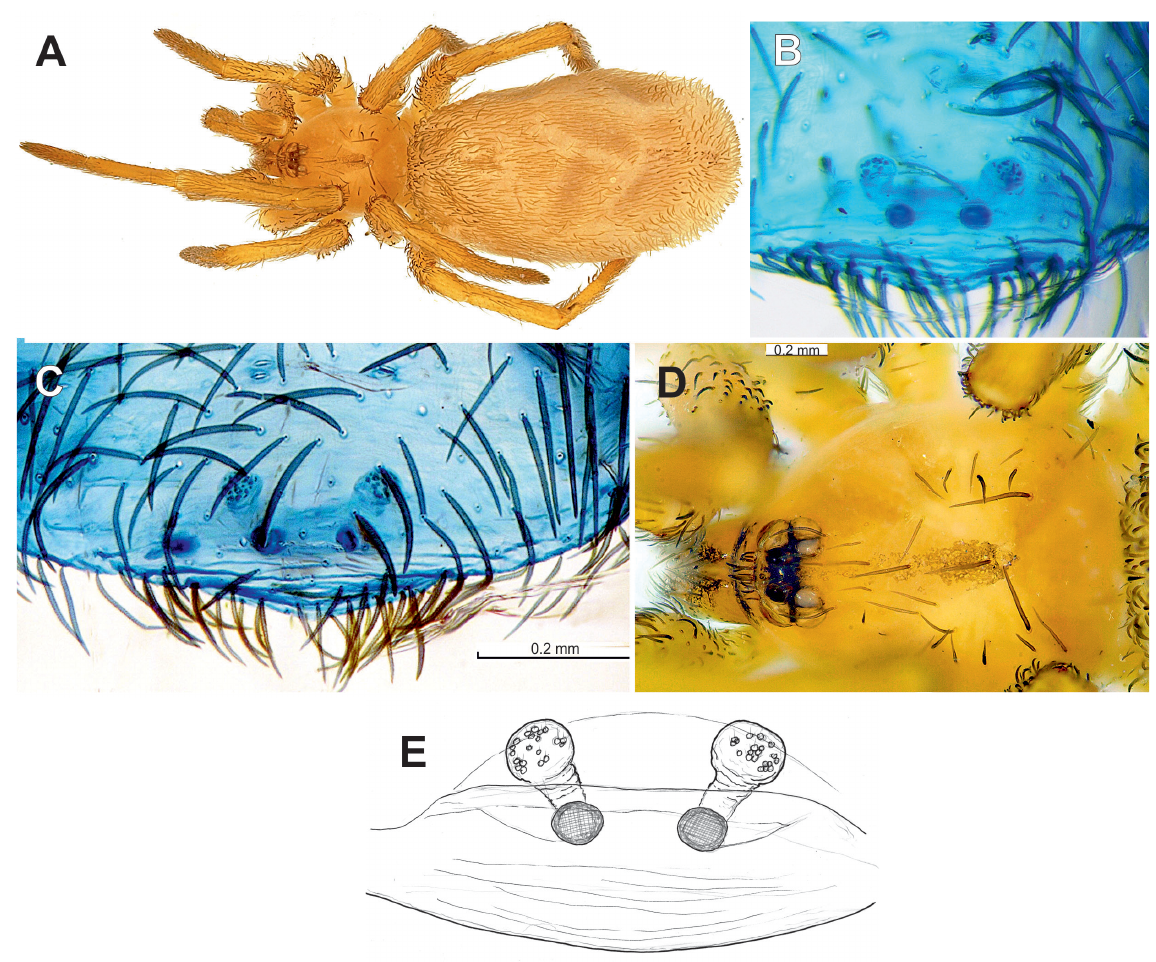
Fig. 22. Somatic characters and endogyne of Zaitunia inderensis Ponomarev, 2005, paratype, ♀. A . Habitus, dorsal. B–C , E . endogyne, dorsal. D . Prosoma, dorsal. Scale bars: a, C–D = 0.2